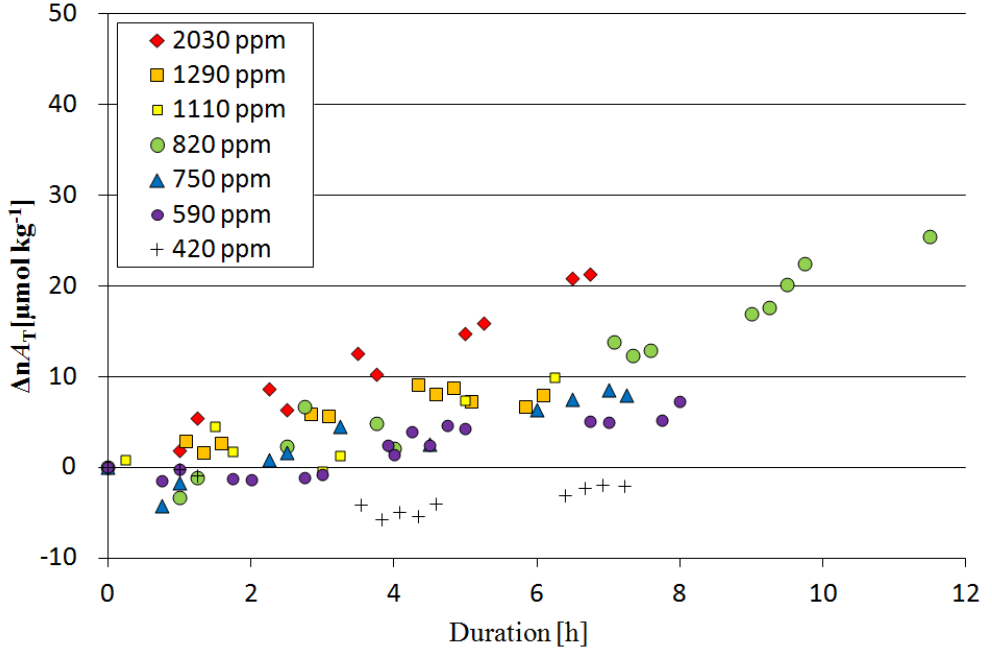
Fig. 5. The result of bulk dissolution experiment (n A T and